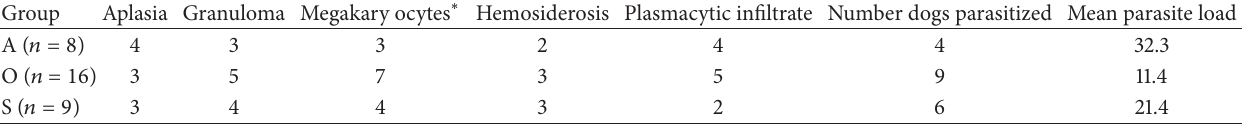
Table 1: Proportion of histopathological changes and the mean parasite burden in the bone marrow of dogs with visceral leishmaniasis. Group